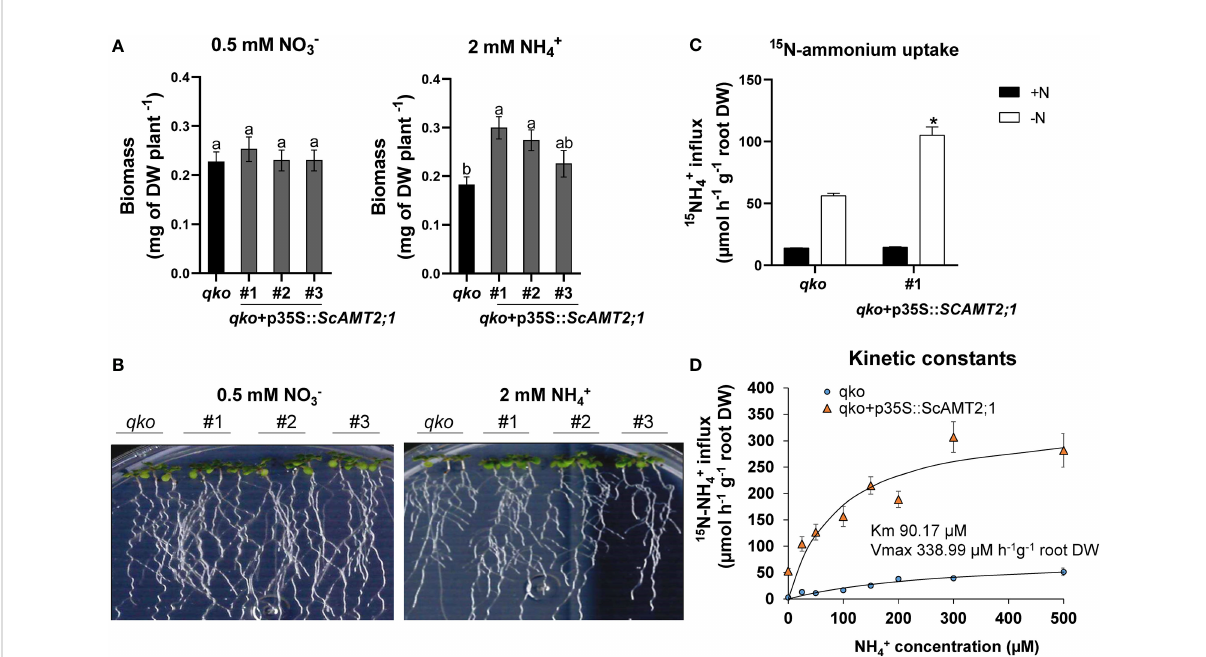
FIGURE 4 Functional evaluation of complemented Arabidopsis qko mutant. (A) Total biomass (DW, dry weight) of homozygous lines of Arabidopsis overexpressing ScAMT2;1 ( qko +p35S:: ScAMT2;1 ) subjected to either 0.5 mM KNO 3 (NO3-) or 2 mM NH 4 Cl (NH 4+ ) for 14 d. Bars indicate means ± SE ( n = 6). Different letters indicate signi fi cant differences among means according to Tukey ’ s test ( p ≤ 0.05). (B) Phenotype of qko and transgenic events grown in vitro under different N sources. (C) In fl ux of 15 N-labeled ammonium into the roots of qko and a transgenic line (#1) overexpressing ScAMT2;1 subjected to either N-free (-N) or 0.2 mM NH 4+ (+N) nutrient solution for 3 d. Bars indicate means ± SE ( n = 4). Asterisks indicate signi fi cant differences between qko and the transgenic line according to Student ’ s t test ( p < 0.05). (D)